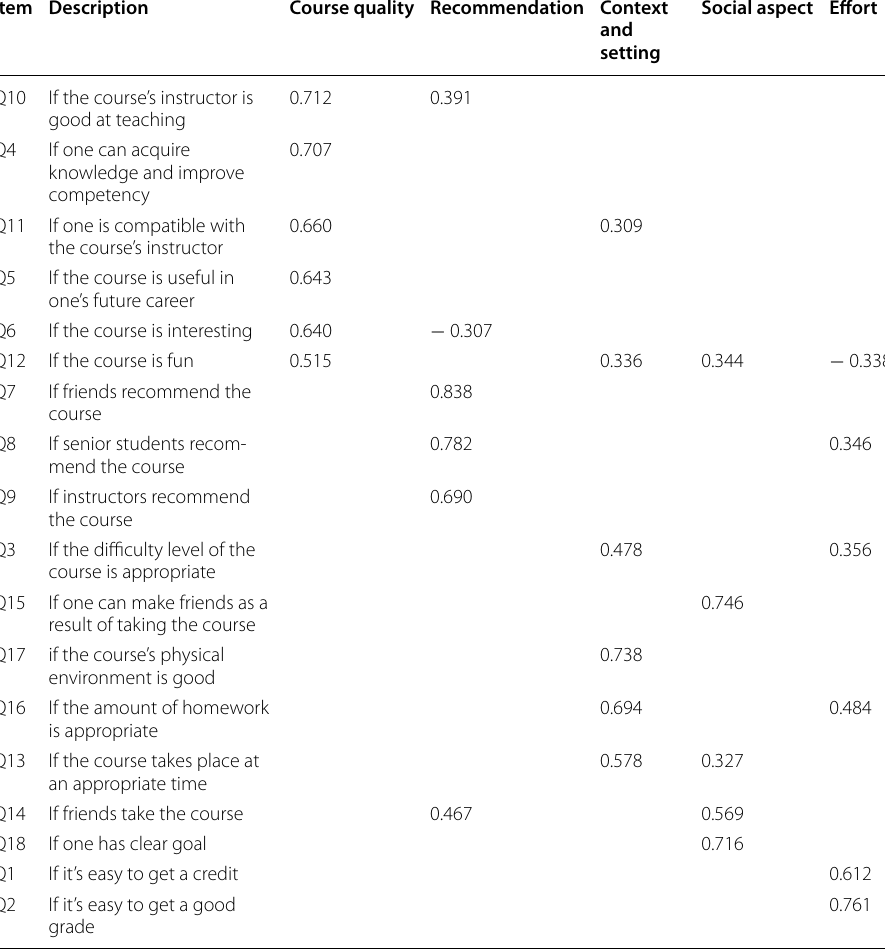
Table 3 Factor loadings and communalities based on a principal components analysis with varimax